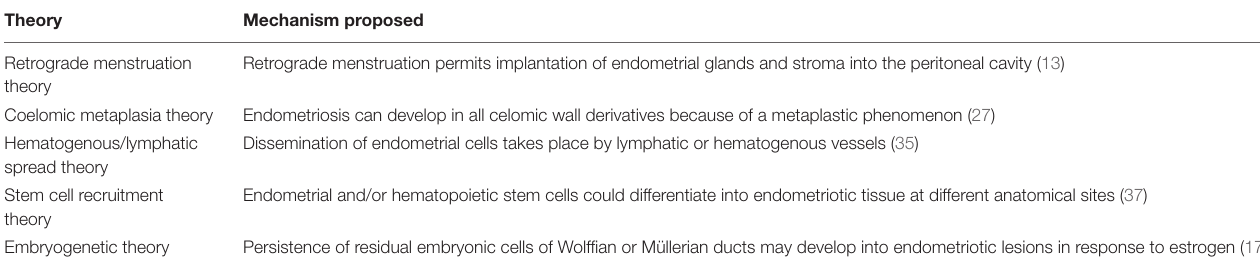
TABLE 1 | Theories proposed for the etiology of